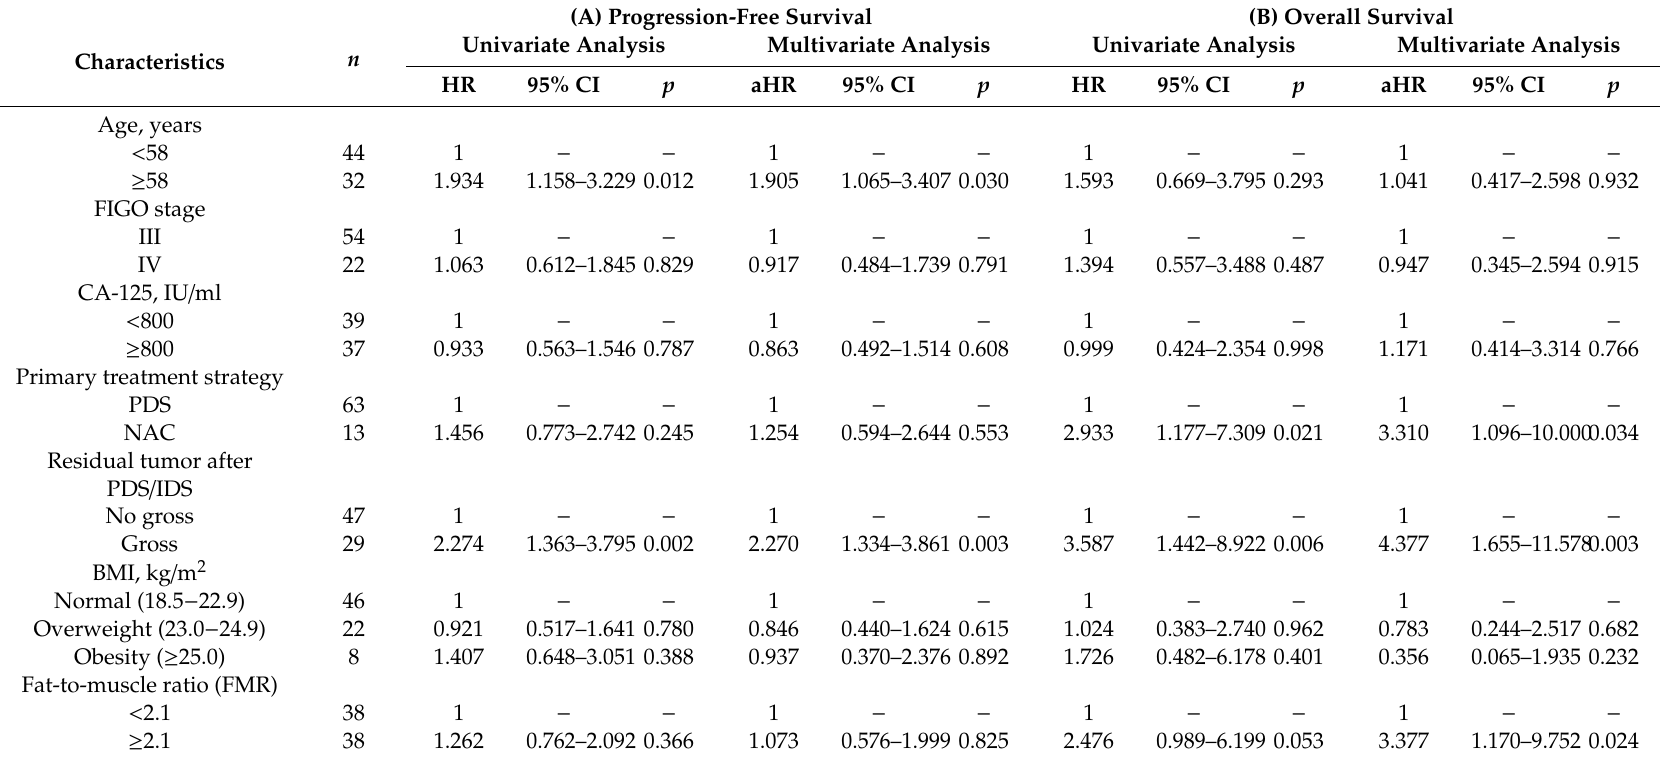
Table 6. Factors associated with sarcopenia patients’ survival